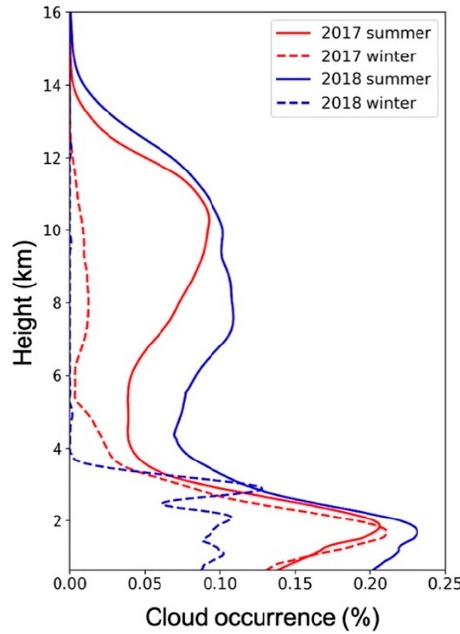
Figure 5. Probability of cloud occurrence (%, normalized to 1) observed during summer (solid line) and winter (dashed line) 2017 (red) and 2018 (blue) as a function of height.